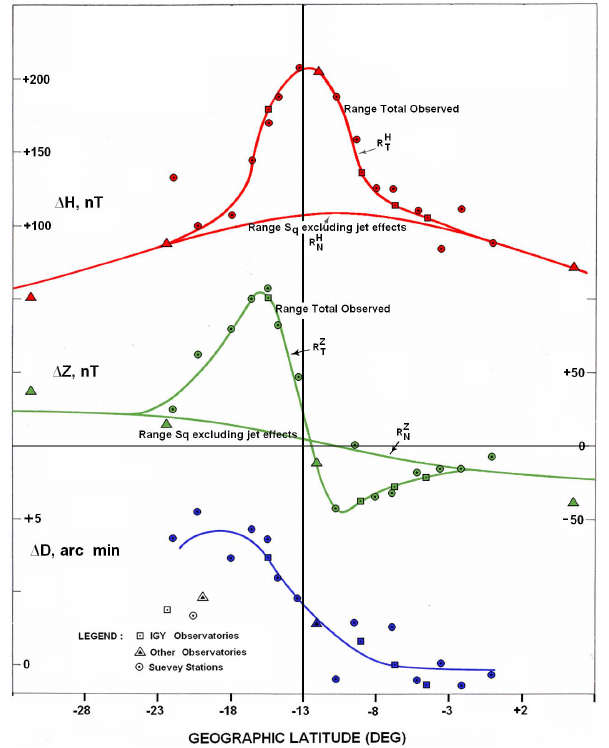
Fig. 14. Latitudinal variations of 1H , 1Z and 1D at 75 ◦ W lon- gitude sector during International Geophysical Year (after Forbush and Casaverde, 1961).